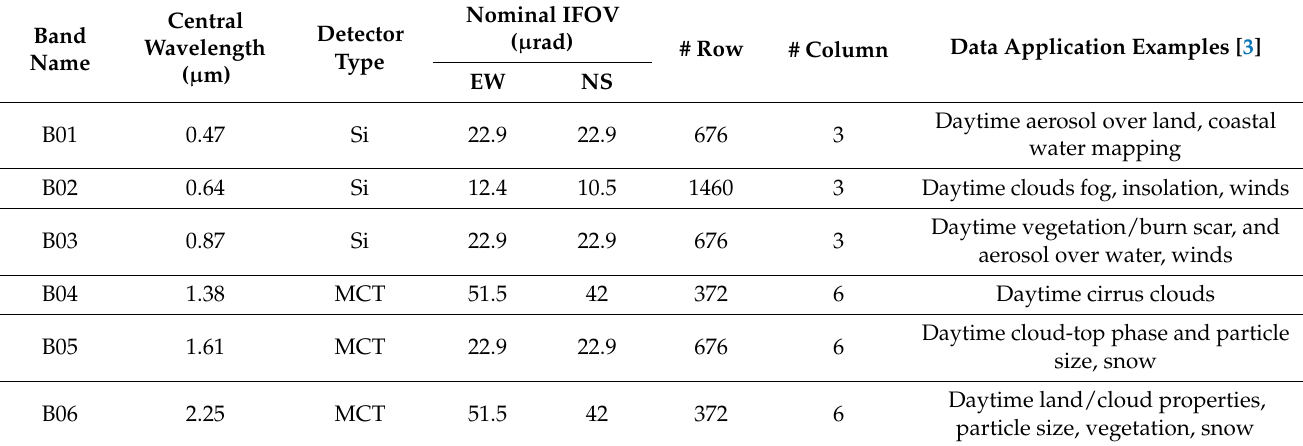
Table 1. Characteristics of ABI VNIR bands. MCT = Mercury Cadmium Telluride (HgCdTe); Si =